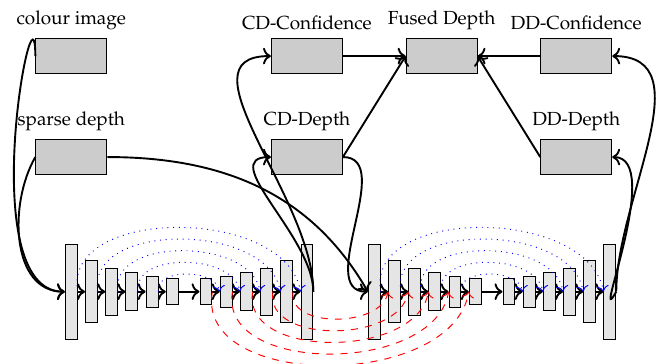
Figure 6. The inputs shown are the colour image and the sparse depth which are inputted into the network to compute the fused depth map which is then further refined. The blue connections show where the features are combined with addition and the red connection show where they are combined with